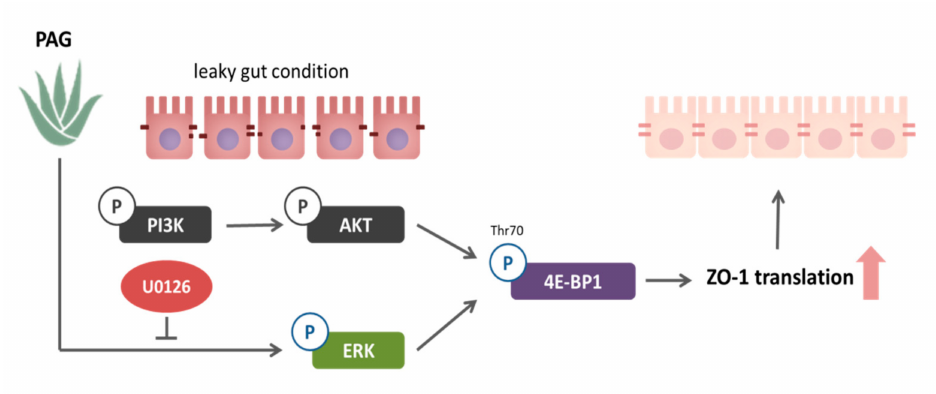
Figure 5. Schematic representation of the mechanism via which PAG regulates the intestinal barrier. In leaky gut sufferers administered PAG, the MAPK/ERK signaling pathway is activated in the intestinal epithelial cells, leading to Thr70-specific phosphorylation of the translation repressor 4E-BP1, resulting in a translational increase in the tight junction related protein ZO-1, to finally reinforcing the intestinal tight